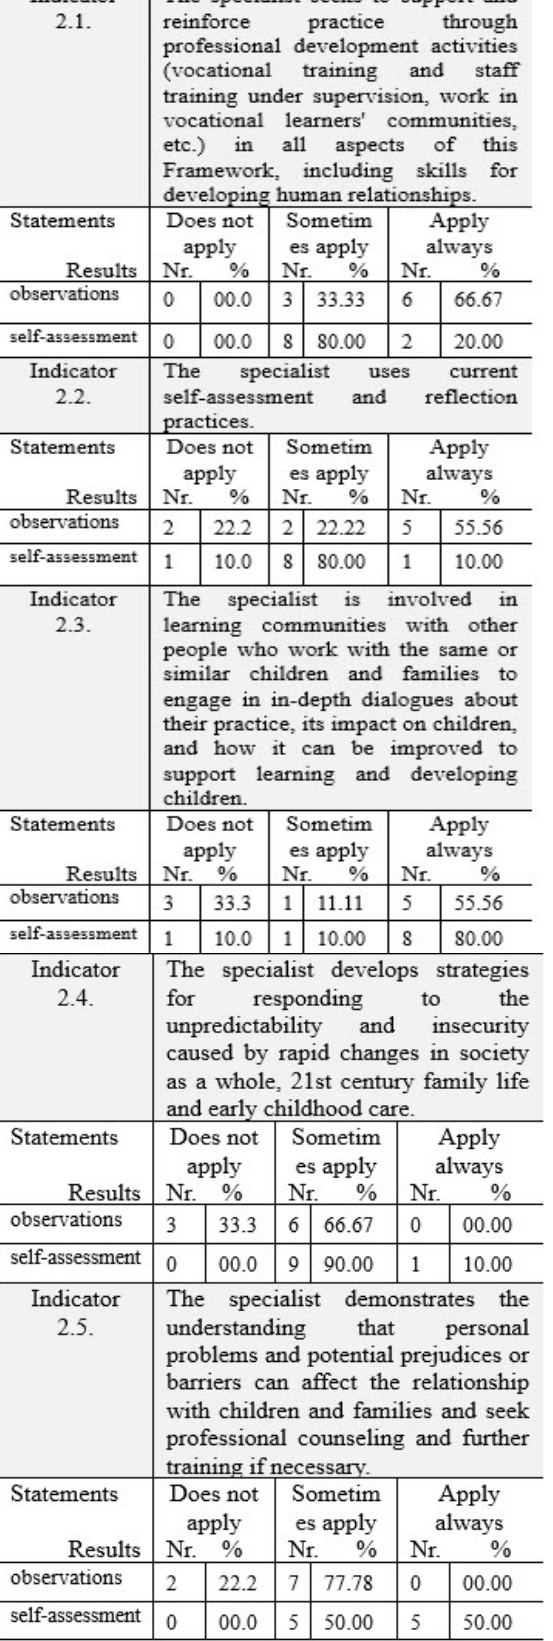
Table 33. Principle 1: Interaction